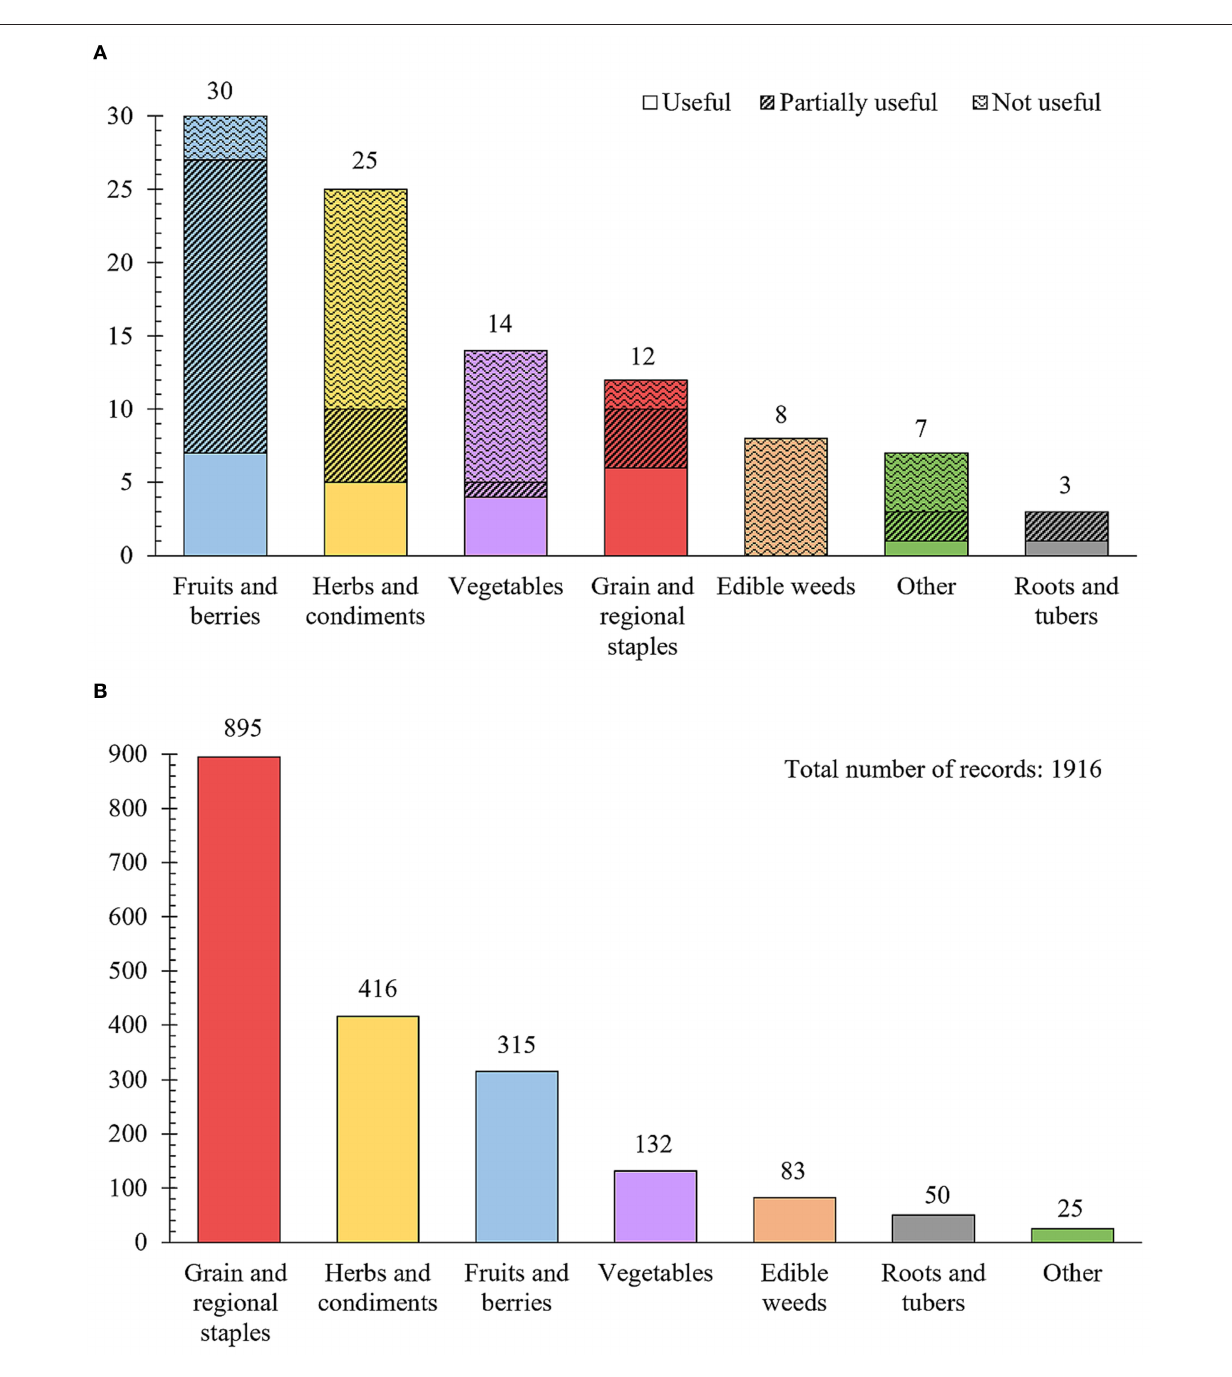
total number of stands (market size) and the total richness of food plants of the local merchants ( R 2 = 0.74 and P <